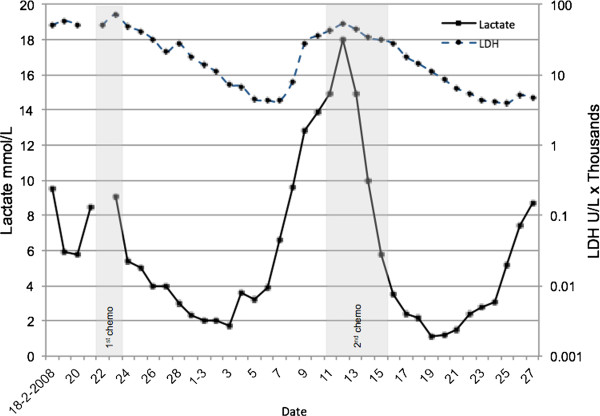
Lactate levels and LDH levels in a patient with a lymphoma admitted to the ICU because of respiratory failure. Following diagnosis, treatment with chemotherapy was started. The effect of the first and second chemotherapy on lactate and LDH is shown.